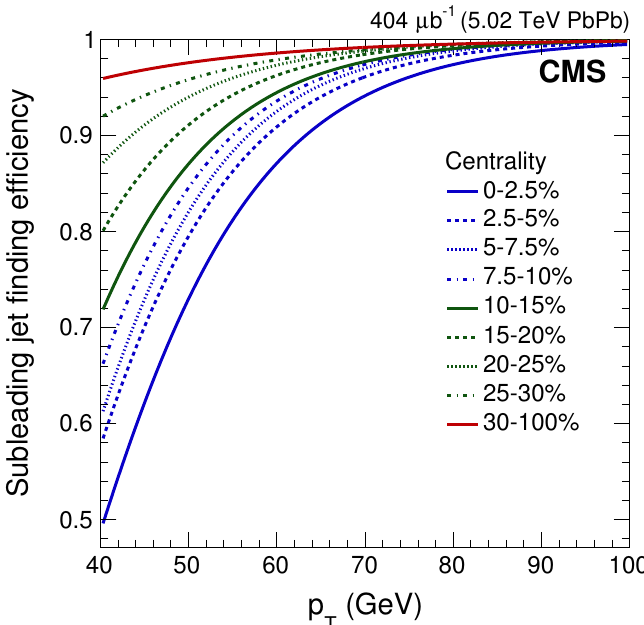
Figure 3 . The e(cid:14)ciency of (cid:12)nding a signal partner jet as function of its p T in PbPb collisions, as evaluated from the small-angle jet pair control region. The corrections are shown in the (cid:12)ne centrality bins used in the